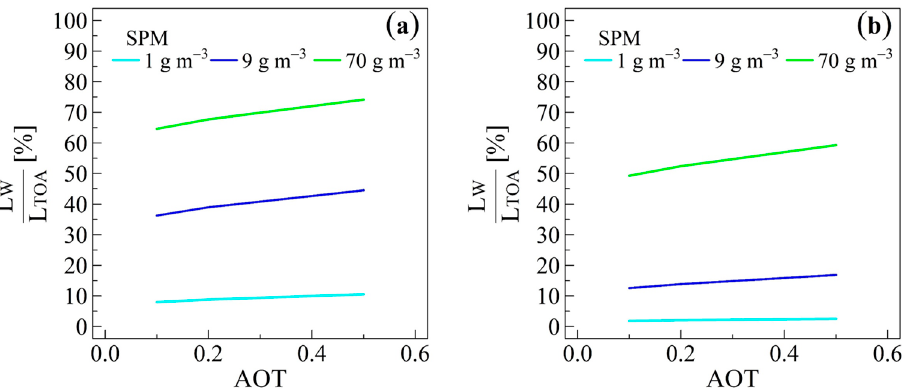
Figure 6. Variation of the ratio L w / L TOA (in %) in the specular direction ( θ v = + 30 ◦ , ϕ OSOAA = 0 ◦ ) as a function of the aerosol optical thickness aerosol optical thickness (AOT) for various SPM concentrations, namely 1, 9, and 70 g m − 3 : ( a ) at 560 nm; ( b ) at 620 nm.